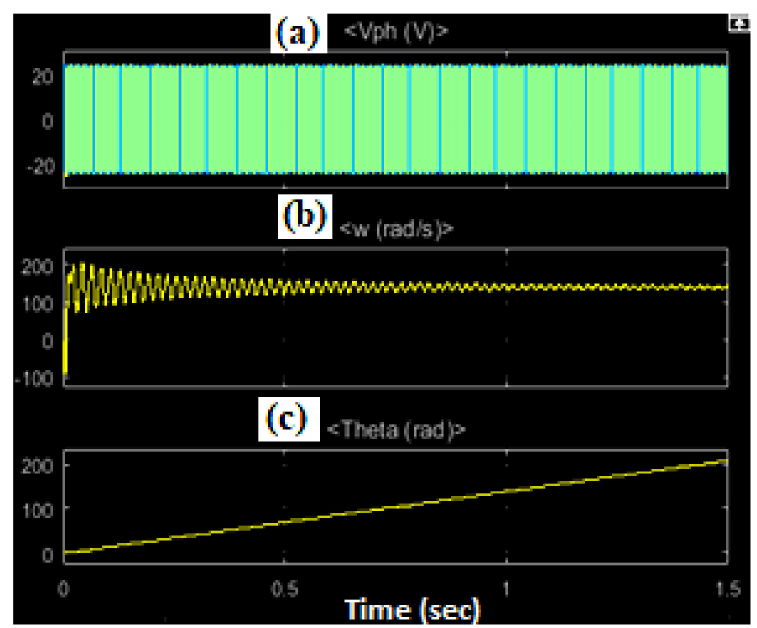
Figure 11. Results of the model in the Simulink libraries at T L = 0.2 Nm and period of time 0.015 s: ( a ) phase voltages, ( b ) speed, and ( c ) displacement angle.